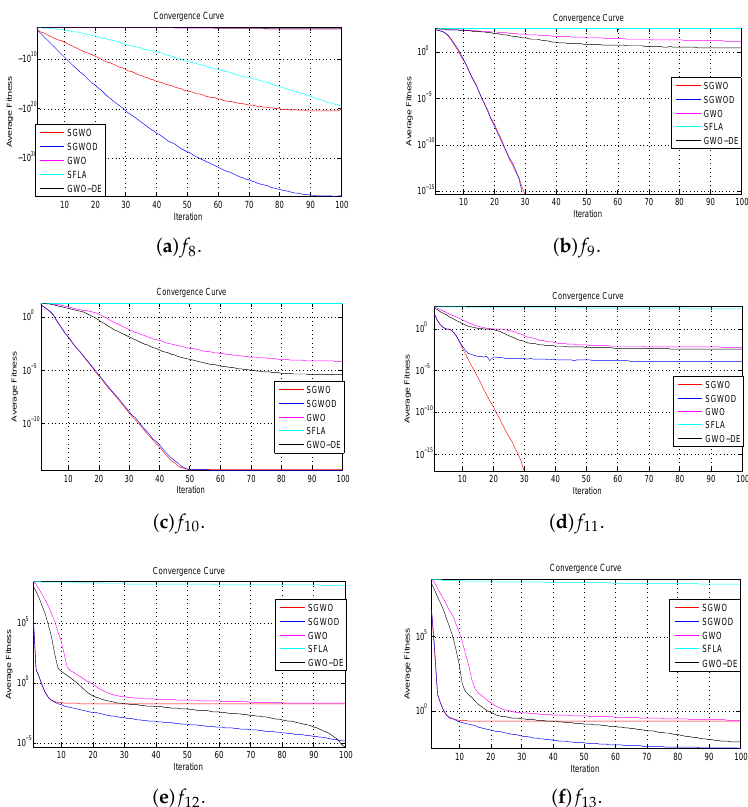
Figure 7. Convergence curves of multimodal benchmark